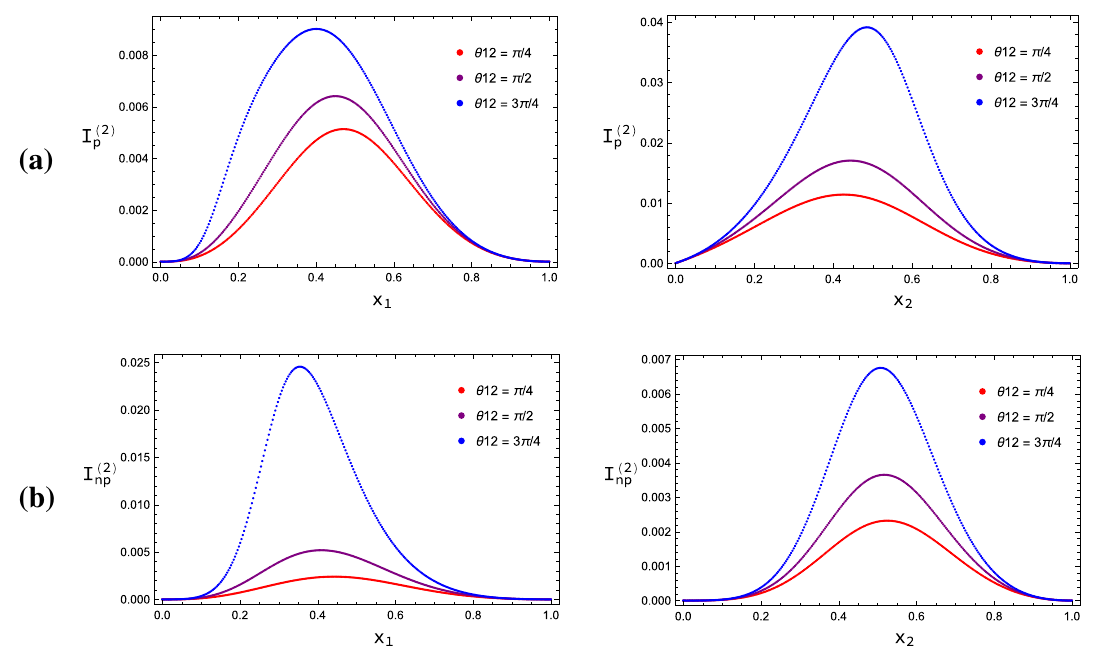
Fig. 8 Numerical stability of the integrands of the two-loop a planar and b non-planar scalar triangles of Fig. 6 with random samplings of x 2 and x 1 in the left and right plots,